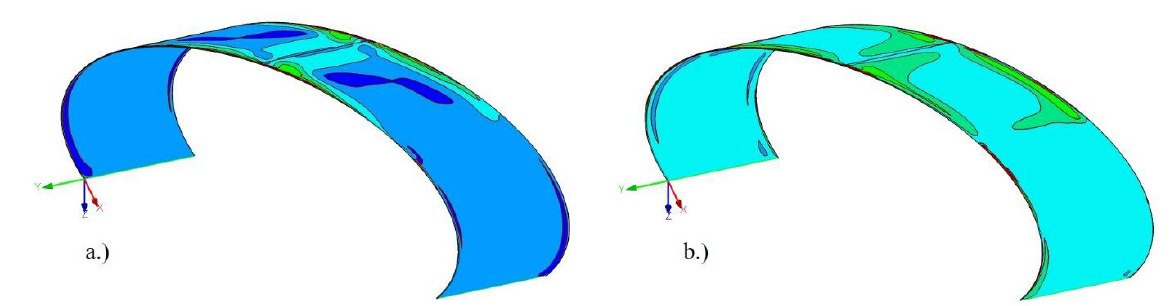
Fig. 14 Results of Finite model of the bridge “Wrapping” a.) load combination with snow, b.) load combination with